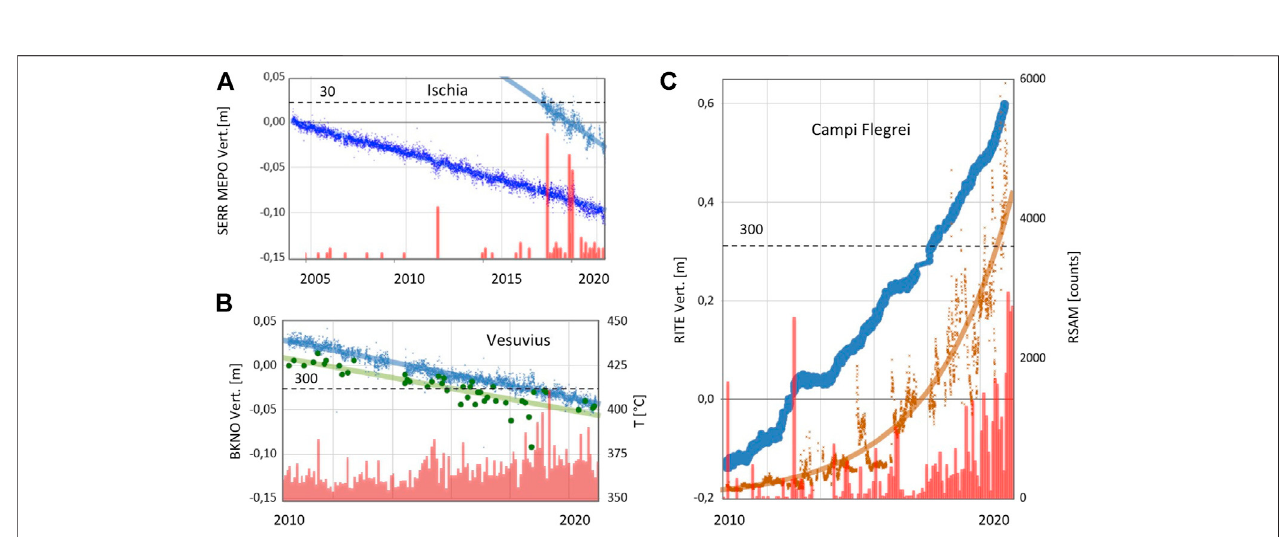
FIGURE14|(A) TimeseriesofseismicandgeodeticparametersrecordedinIschiafrom2004to2020.Inlightbluethedailytime series(2017 – 2020)ofthevertical component of MEPO GPS station and in blue the daily time series (2004 – 2020) of the vertical component of SERR GPS station (see Figure 4 for station locations) in meters(alinear trendlineisdrawn). In red,thehistogram ofthemonthly occurrence ofearthquakes fromthe catalogoftheOC9station ( Figure 4 ).Thedotted horizontal linemarksthelimitforthehistogramscale(30events/month). (B) Timeseriesoftheseismic,geodeticandgeochemicalparametersrecordedatVesuviusfrom2010 to 2020. In blue the daily time series of the vertical component of BKNO GPS station (site VBKN in Figure 2 ), in meters (a linear trend line is drawn). In green the temperature in Celsius degrees estimated based on the composition of the FC2 and FC5 (since 2018) fumaroles (a linear trend line is drawn). The histogram of the monthly occurrence of earthquakes from the BKE station catalog ( Figures 2 , 8B ) is in red. The dotted horizontal line marks the limit for the histogram scale (300 events/ month). (C) Time series of seismic, geodetic and geochemical parameters recorded at Campi Flegrei from 2010 to 2020. In blue the daily time series of the vertical componentoftheRITEGPSstation( Figure3 ),inmeters.InochertheamplitudeofthefumarolictremoroftheCPISstation,proxyofhydrothermalactivity(anexponential trendlineisdrawn).ThehistogramofthemonthlyoccurrenceofearthquakesfromtheSTHstationcatalog( Figure3 )isinred.Thedottedhorizontallinemarksthelimitfor the histogram scale (300